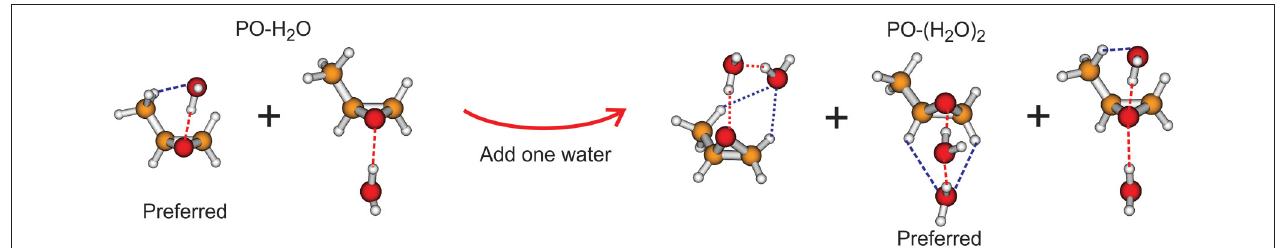
FIGURE 10 | Geometries of the two and three most stable conformers of PO-(H 2 O) 1 , 2 obtained at the MP2/6-311 ++ G(d,p) level of theory, respectively. For the 1:1 Po-water complex, syn PO-water is preferred and for the 1:2 PO-(water) 2 complex, anti PO-(water) 2 is the preferred conformation (Su et al., 2006; Su and Xu,